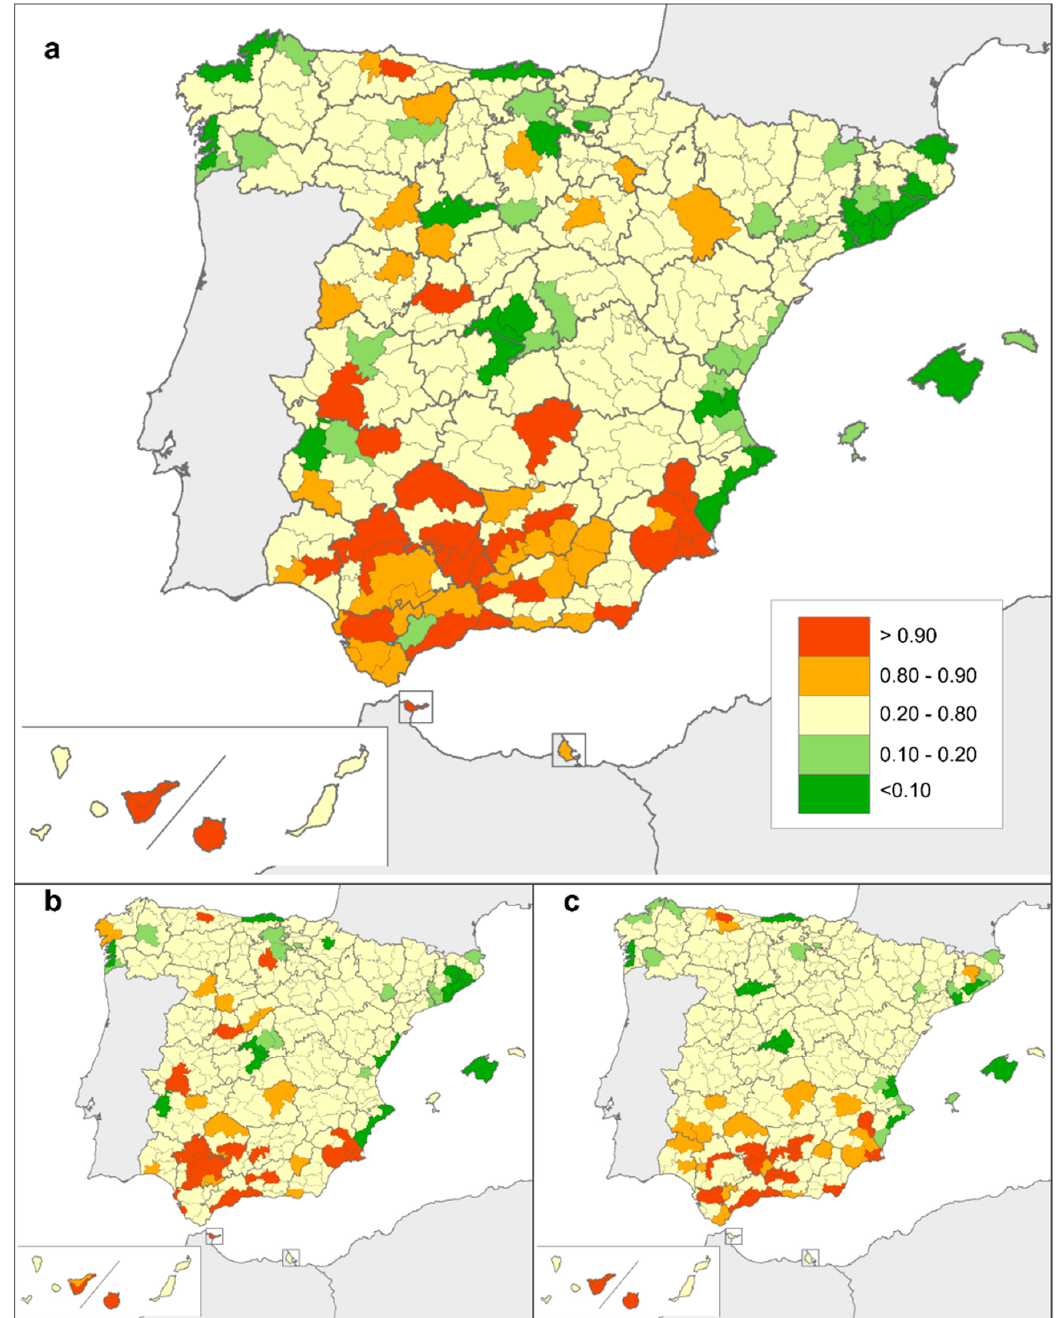
Figure 3. Posterior probability (PP) values for: ( a ) both sexes, ( b ) males, ( c ) females. PP shows those districts with significantly higher (PP > 0.80) and lower (PP < 0.20) than expected (for the country as reference) risk of death due to rare congenital anomalies.